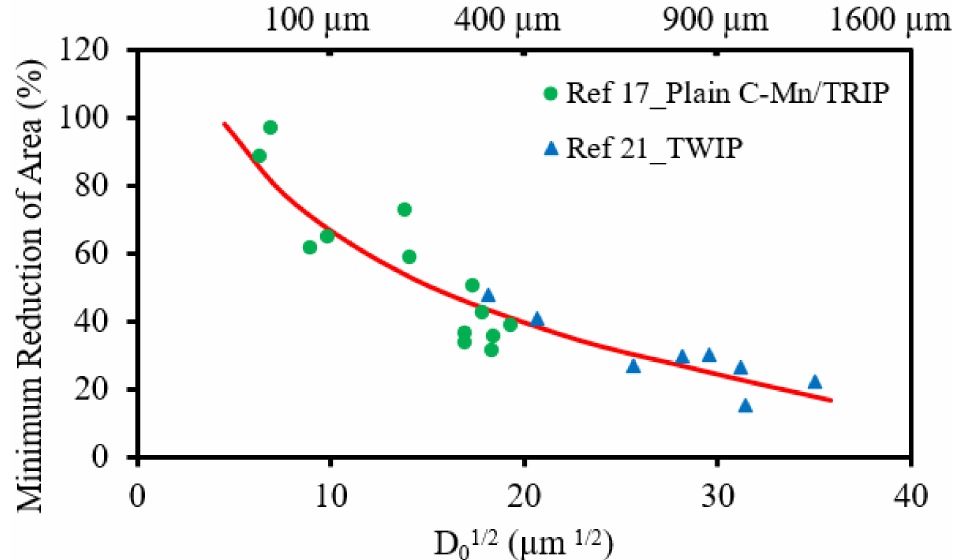
Figure 8. Influence of grain size on the RA value of steels, where D o is the original grain size before deformation for steels having 0.15% C, 1.4% Mn in which precipitation hardening is not